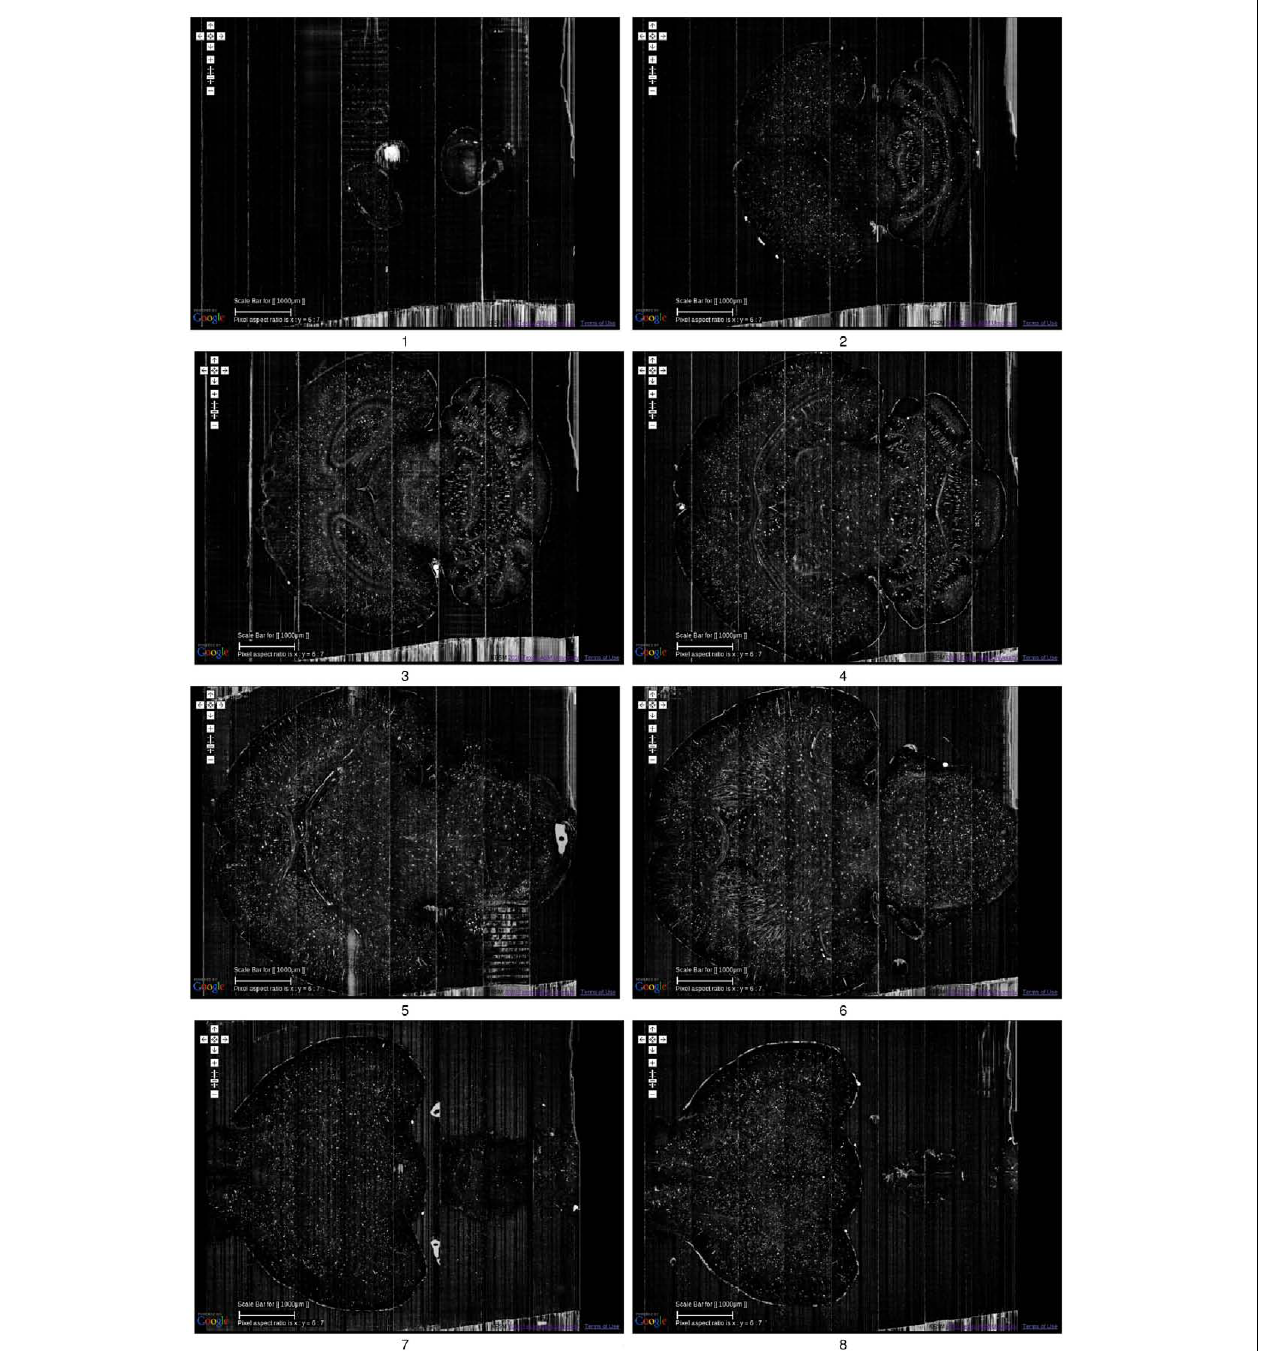
last where it was 200 μ m (so that data from near the bottom of the data stack can be shown: otherwise it will overshoot into regions with no data).The numbers below the panels show the ordering. See Movie S1 in Supplementary Material for a fly-through of this data